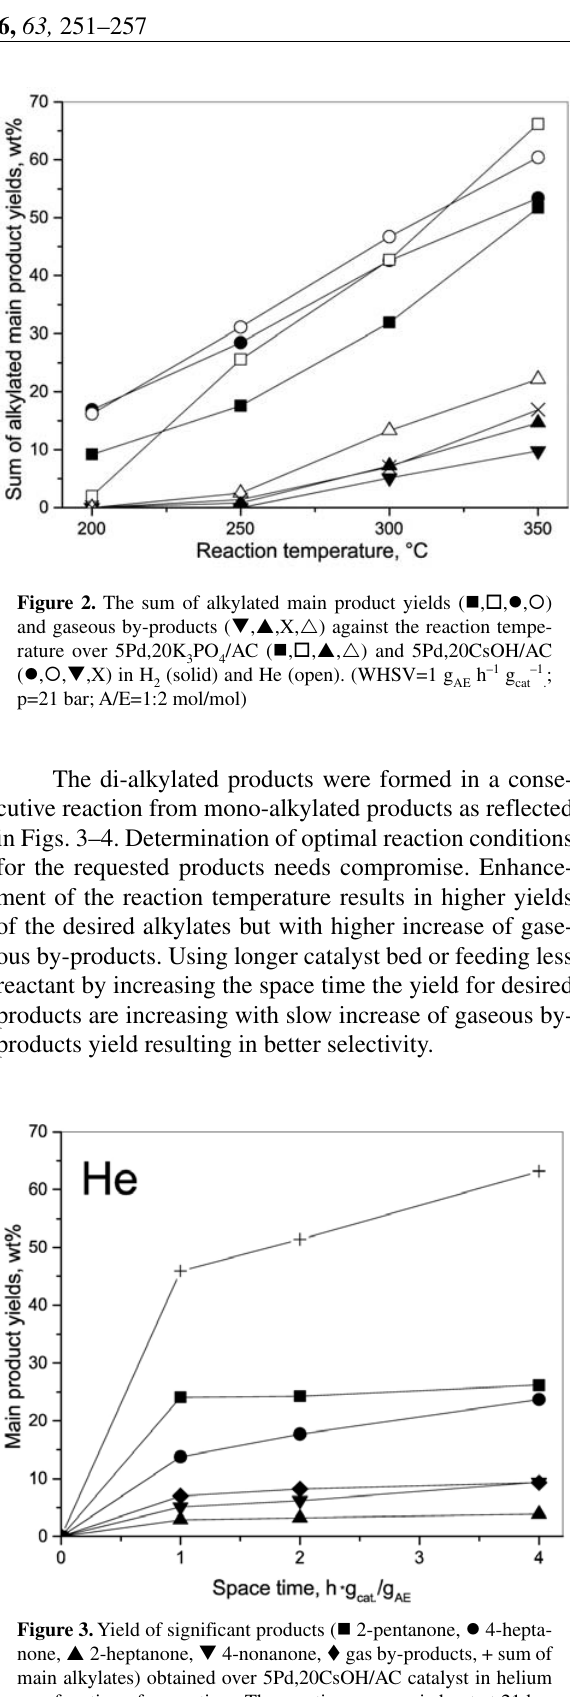
Figure 3. Yield of significant products ( (cid:2) 2-pentanone, (cid:4) 4-hepta- none, (cid:3) 2-heptanone, (cid:2) 4-nonanone, (cid:6) gas by-products, + sum of main alkylates) obtained over 5Pd,20CsOH/AC catalyst in helium as a function of space time. The reaction was carried out at 21 bar total pressure and 300